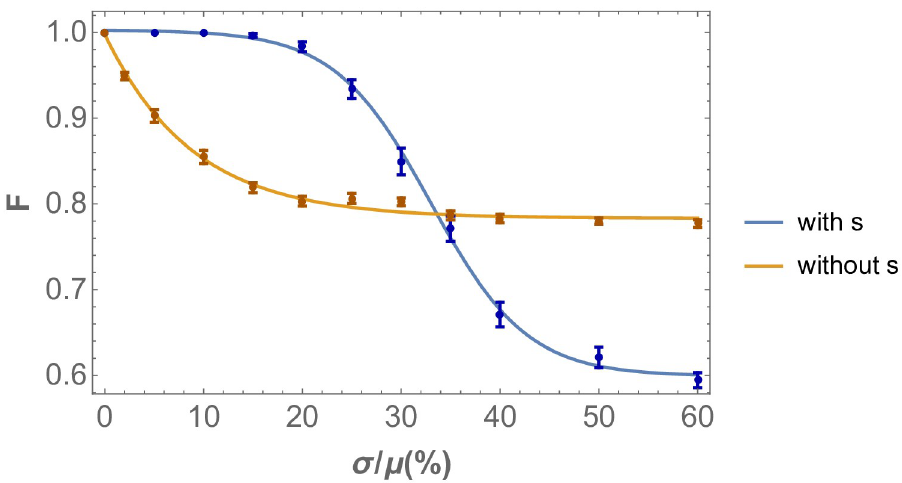
Fig 11. Robustness of Drosophila eye disc R8 cell pattern order versus stochasticity, with and without the diffusible activator Scabrous in the model. The analysis is applied in the same setting as Fig 9, i.e. stochasticity is introduced in the diffusivity of the morphogens D u and D s . In the absence of the diffusible activator s , there is a much increased sensitivity to stochasticity for infinitesimal non-vanishing σ . The order measure used is the fidelity of the nearest neighbor distance probability